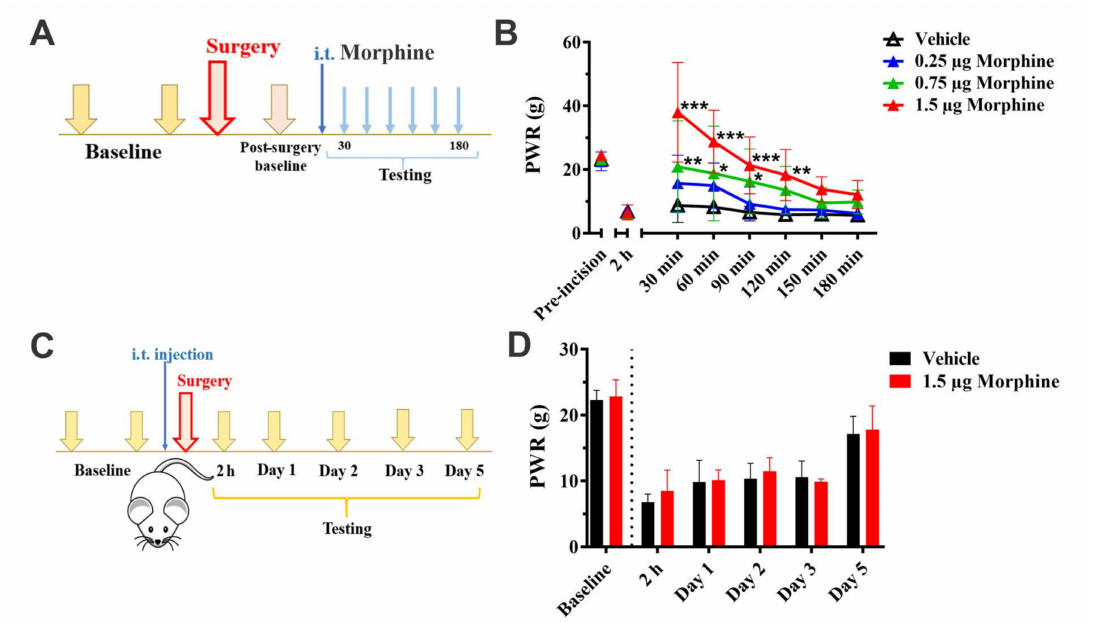
Figure 7. The preemptive administration of morphine does not alleviate post-incisional mechanical hypersensitivity in rats. ( A ). A time-course showing baseline measurements to mechanical stimuli two days before incision, two hours and 24 h after incision. The paw withdrawal responses were measured every thirty minutes after intrathecal (i.t.) injection of morphine (0.25 µ g, 0.75 µ g or 1.5 µ g). ( B ). Morphine significantly increases the mechanical sensitivity threshold in the incised paw in a dose-dependent manner ( n = 8 for Vehicle; n = 7 for 0.25 µ g, n = 9 for 0.75 µ g and n = 8 for 1.5 µ g morphine groups). Each data point is represented as mean ± SD. * p < 0.05, ** p < 0.01 and *** p < 0.001 vs. Vehicle group, Two-way ANOVA followed by Tukey’s post hoc test. ( C ). A time-course showing pre-surgical baseline measurements, the timing of i.t. morphine injection and post-surgical testing time points. ( D ). Preemptive treatment of 1.5 µ g morphine does not reduce mechanical hypersensitivity after surgery ( n = 9 for Vehicle and n = 5 for 1.5 µ g morphine group). Each data point is represented